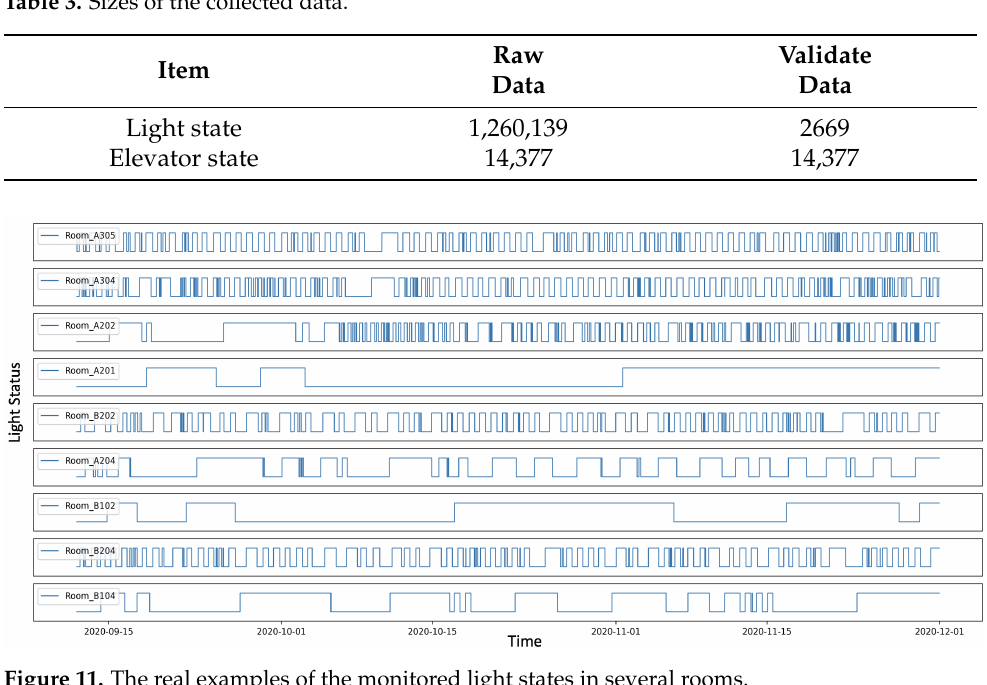
Table 3. Sizes of the collected data.